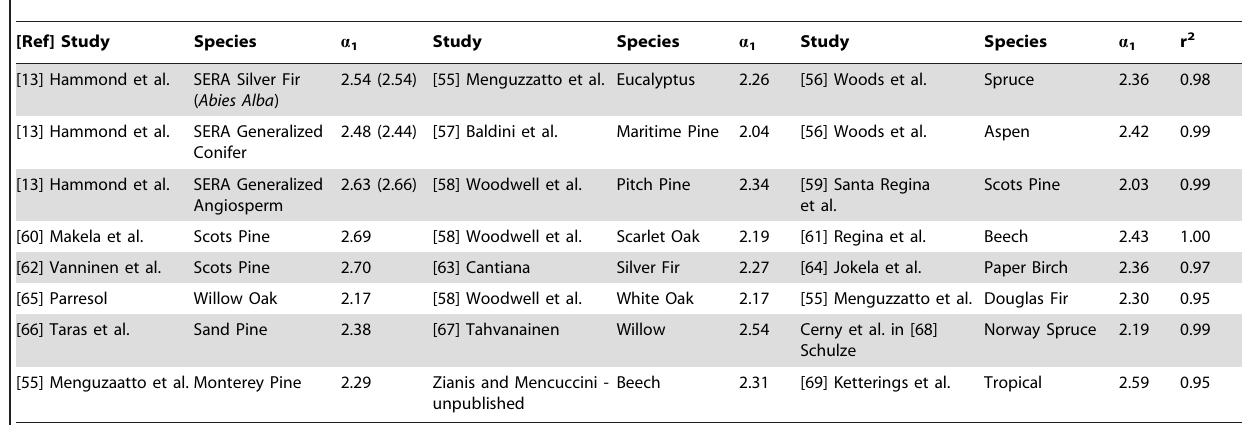
Table 1. Reported scaling exponents a 1 for H-D relationship taken from referenced